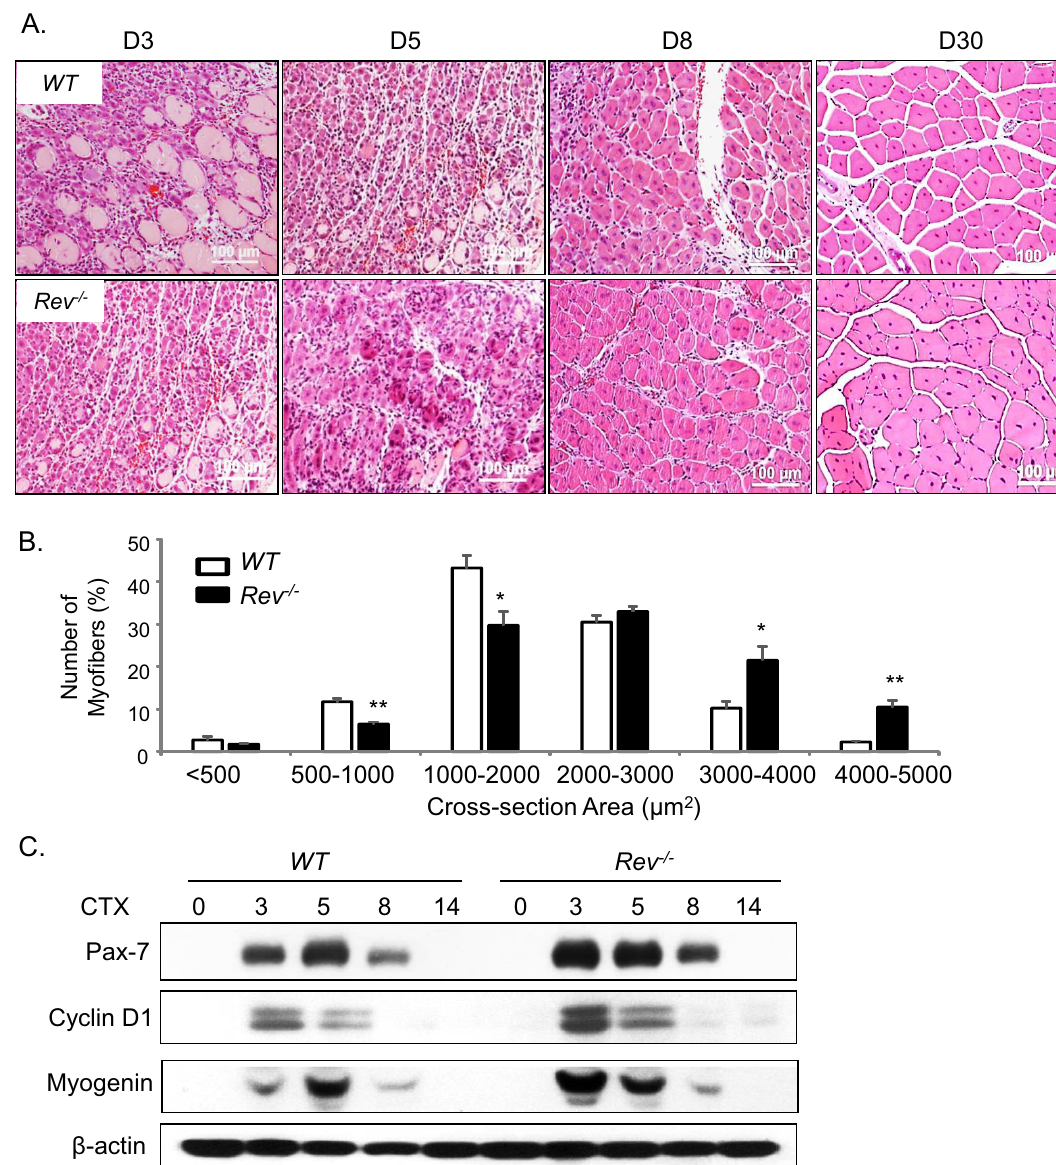
Figure 8. Loss of Rev-erbα enhances muscle regeneration. ( A ) Representative images of H/E histological analysis of muscle regeneration at 3, 5, 8 and 30 days. The number of mice used for these analysis are: day 0 (WT n = 6, Rev−/− n = 6), day 3 (WT n = 6, Rev−/− n = 5), day 5 (WT n = 7, Rev−/− n = 6), day 8 (WT n = 5, Rev−/− n = 6), day 14 (WT n = 6, Rev−/− n = 5), day 30 (WT n = 6, Rev−/− n = 8). ( B ) Quantitative analysis of regenerated myofiber diameter distribution at 30 days after cardiotoxin injury in WT (n = 6) and Rev−/− mice (n = 8). Values are represented as the percentage of number of myofibers within the indicated range over total number of myofibers. Three representative 10X sections with ~ 450 total myofibers were counted for each mouse in the group. Non-parametric Kruskal–Wallis ANOVA for dataset p-value < 0.0001, and non-parametric Mann–Whitney test are indicated for individual cross section area category: ***P ≤ 0.05 or 0.01 Rev−/− vs. WT. ( C ) Immunoblot analysis of protein levels of cell cycle regulator and myogenic marker in regenerating TA muscle lysate at indicated time points after CTX injury. Protein samples were pooled from each group of WT or Rev−/− at indicated time point as shown in ( A